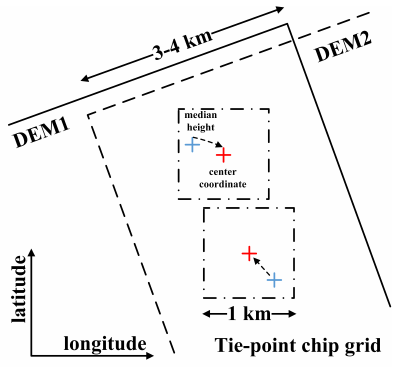
Figure 1. Extraction of TP chips. The dashed box indicates the tie point chip, the red mark is the center point, and the blue mark is the location of the elevation